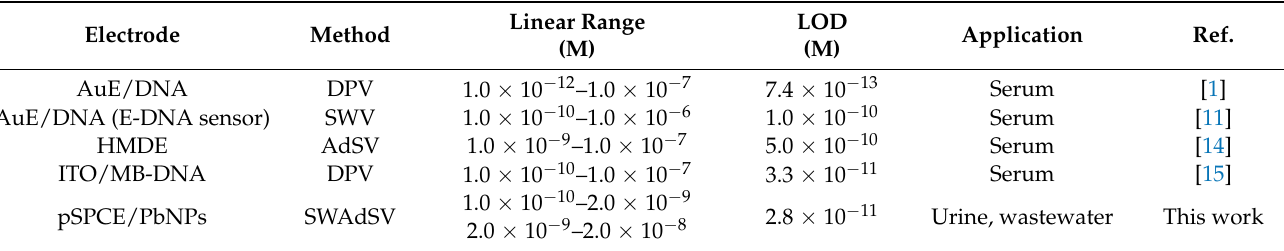
Table 2. Comparison of voltammetric analyses of BLM.